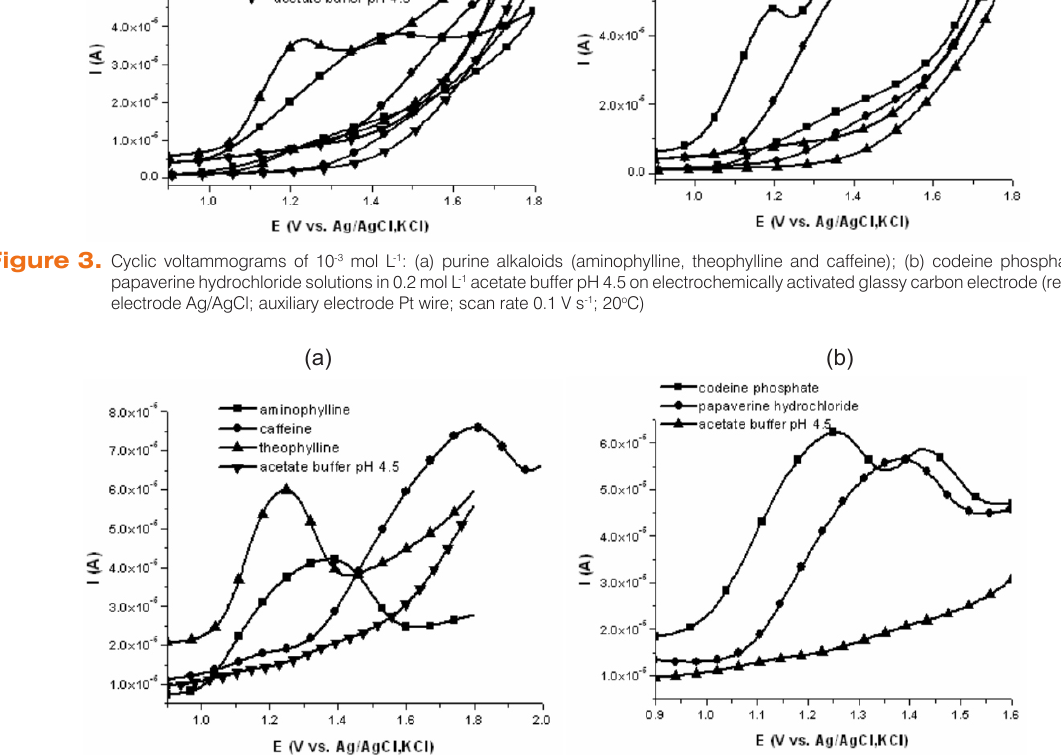
Figure 4. Square-wave voltammograms of 10 -3 mol L -1 : (a) purine alkaloids (aminophylline, theophylline and caffeine) ); (b) codeine phosphate and papaverine hydrochloride solution in 0.2 mol L -1 acetate buffer pH 4.5 on electrochemically activated glassy carbon electrode (reference electrode Ag/AgCl; auxiliary electrode Pt wire; frequency 75 Hz; amplitude 50 mV; scan increment 5 mV; 20 o